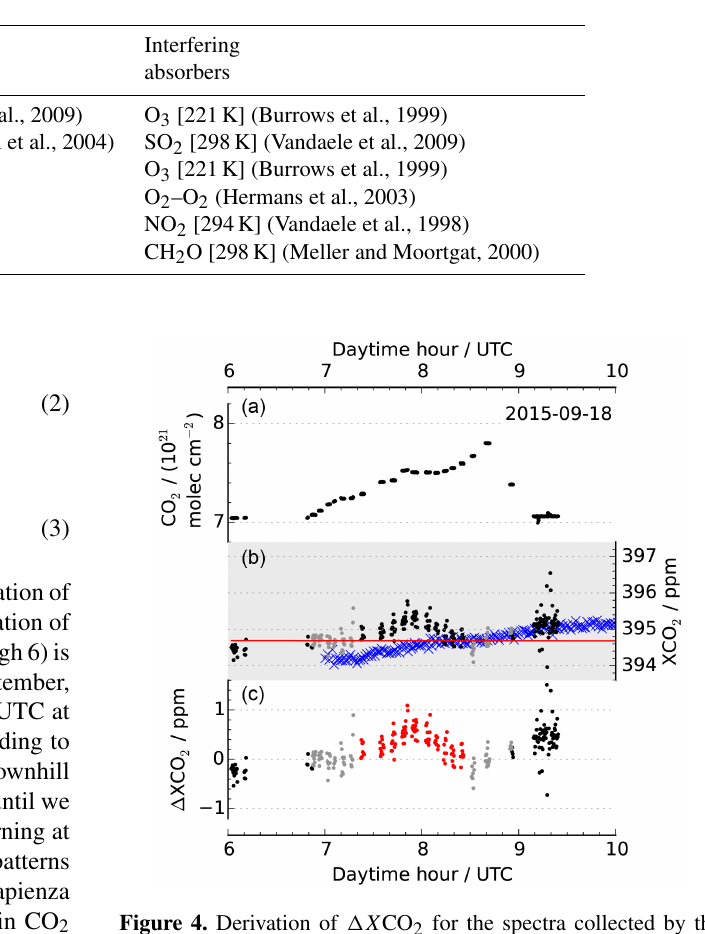
Table 2. Spectral retrieval windows and their properties used for processing the absorption spectra in the UV. Brackets following absorber molecules indicate the reference temperatures at which the absorption cross sections were measured in the laboratory. Parentheses contain references to the relevant data sources.